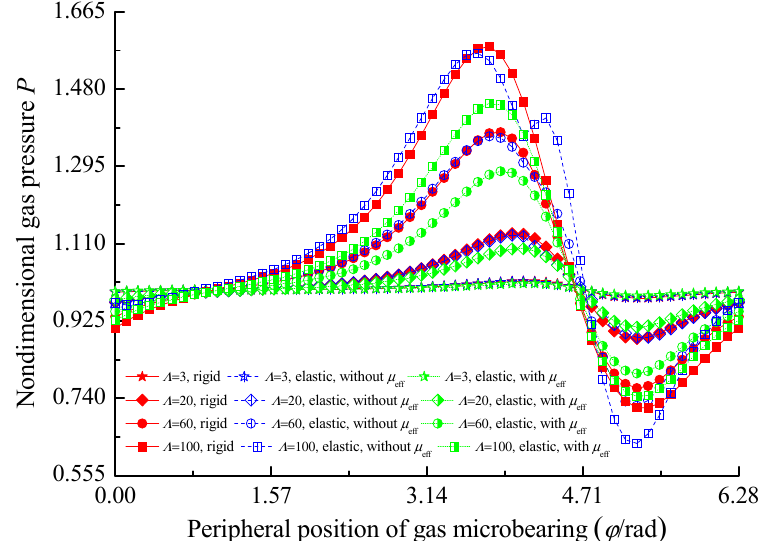
Figure 4. Pressure distributions of the gas microbearing for different bearing numbers ( ε = 0.6, E = 300 GPa, υ = 0.3).